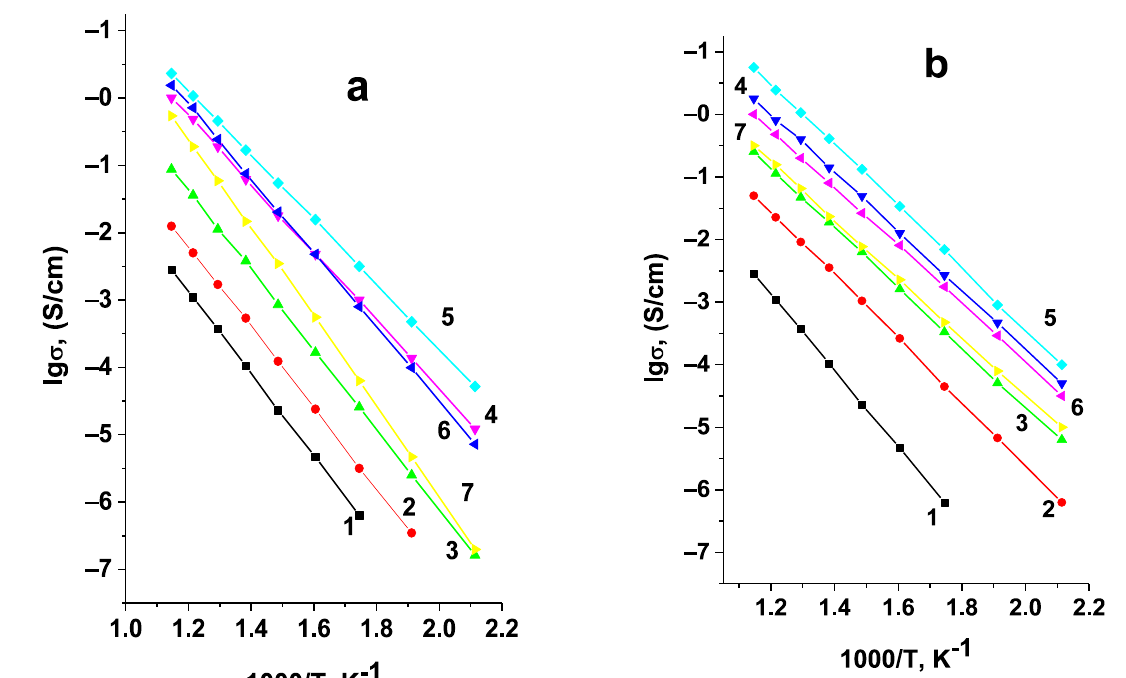
Figure 10. Arrhenius plots for conductivity of Li 6-x Zr 2-x A x O 7 A = Nb ( a ), Ta ( b ); x = 0(1); 0.05(2); 0.10(3); 0.15(4); 0.20(5); 0.25(6); 0.30(7).